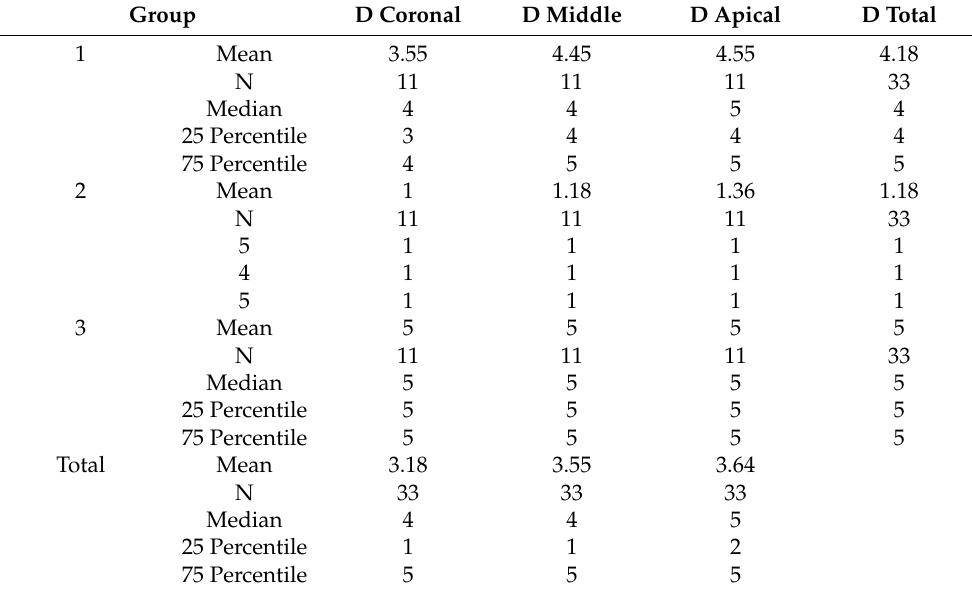
Table 1. Means, medians, 25 and 75 percentiles per group, D: Debris.